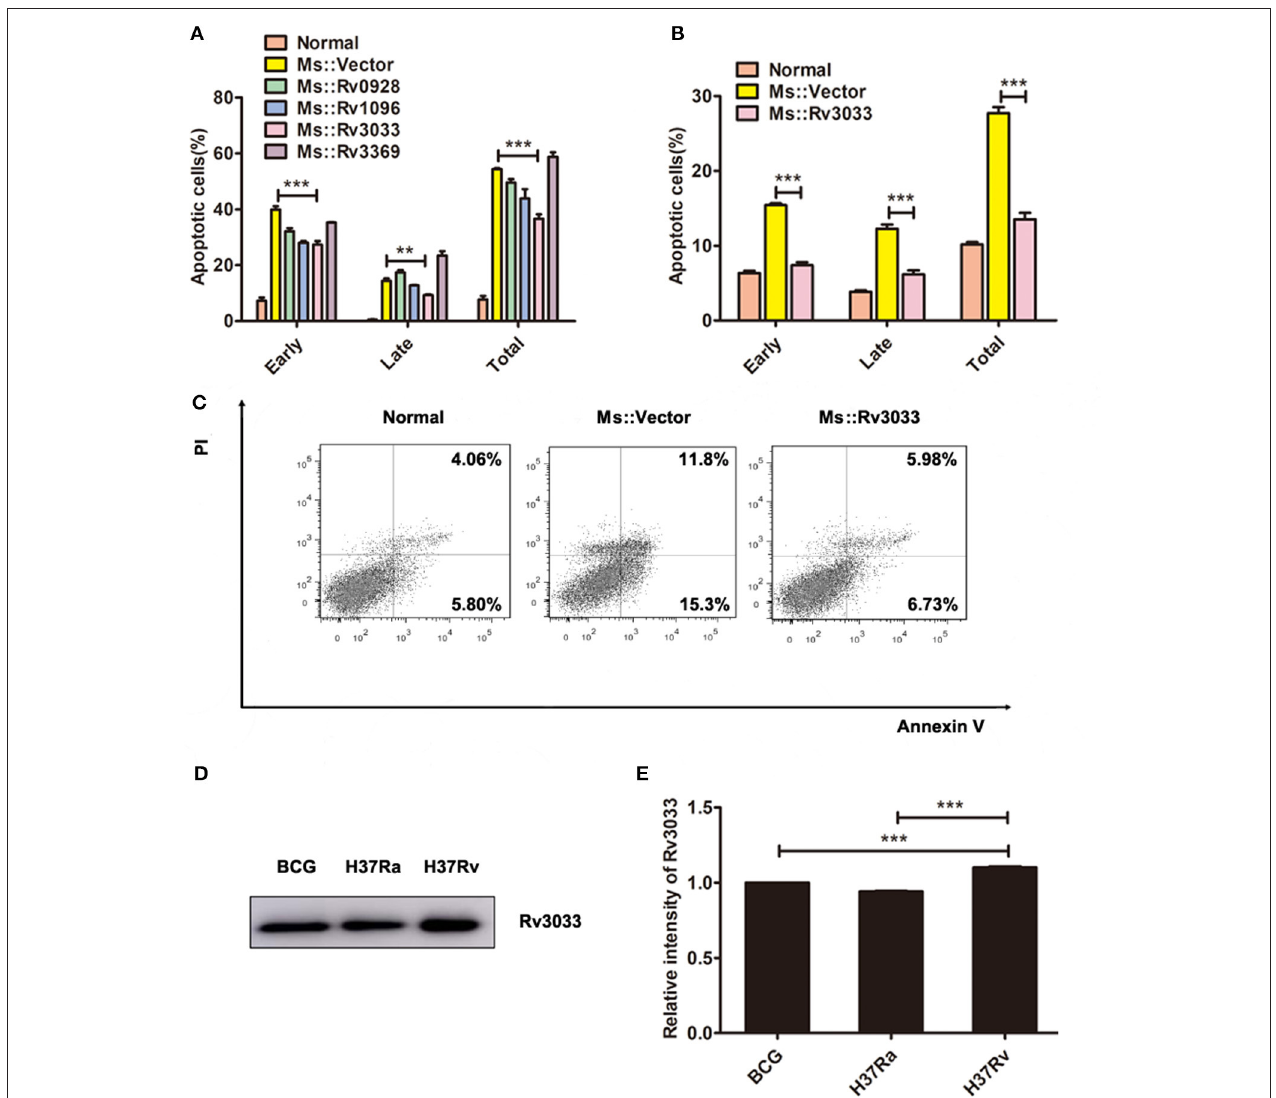
FIGURE 2 | Rv3033 potently suppressed mycobacteria-induced macrophage apoptosis. (A) RAW264.7 cells were infected with Ms::Vector, Ms::Rv0928, Ms::Rv1096, Ms::Rv3033, or Ms::Rv3369 (MOI = 10) for 48h. The percentages of early, late, and total apoptotic cells in FACS assay. (B,C) BMDM cells were infected with Ms::Vector or Ms::Rv3033 for 48h, apoptotic cells were determined by Annexin V/PI staining assays. The percentages of early, late and total apoptotic cells in FACS assay. (D) The protein expression levels of Rv3033 in BCG, H37Ra, and H37Rv pellets were determined by western blot. (E) Semi-quantification of Rv3033. Data are performed as the mean ( ± SEM) and from one representative experiment of three independent experiments. (** p < 0.01; *** p < 0.001).